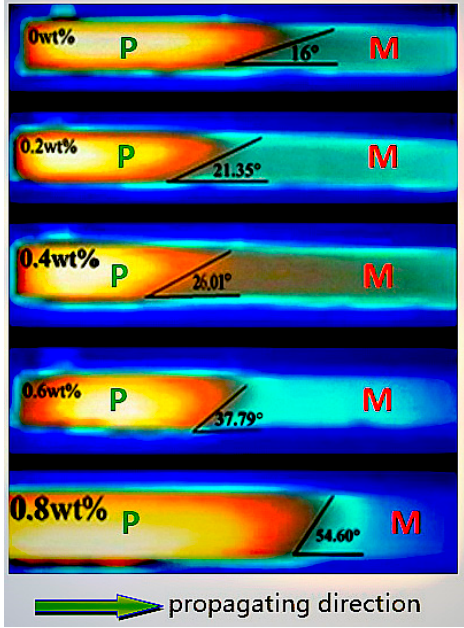
Figure 7. The propagating angles observed during the preparation of the epoxy resin nanocomposites via the PIFP approach with various contents of PABA-modified MWCNTs. These images were recorded using an infrared thermal imager. P, polymers (cured products); M, monomers (mixture of epoxy oligomers, PI, and TI). Each PIFP reaction propagated horizontally to the right.